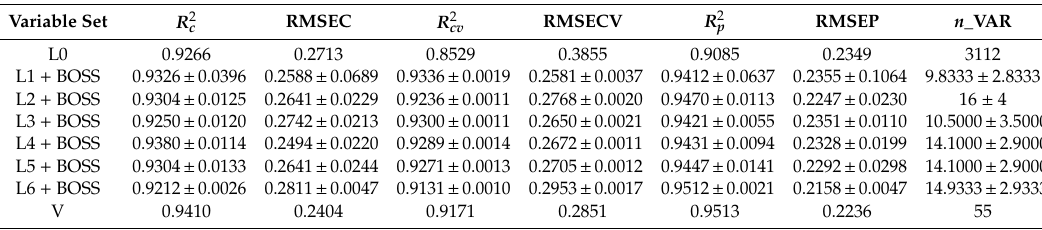
Table 1. Results of di ff erent PLS models by di ff erent deposition layers.